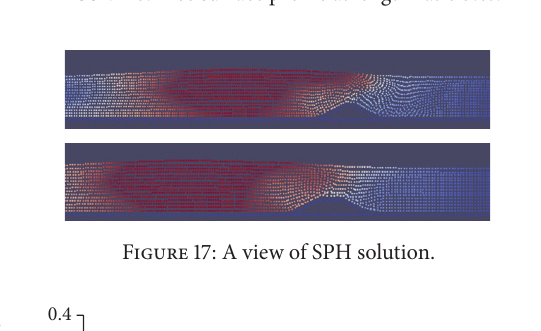
Table 8: Effects of breakwaters distance.